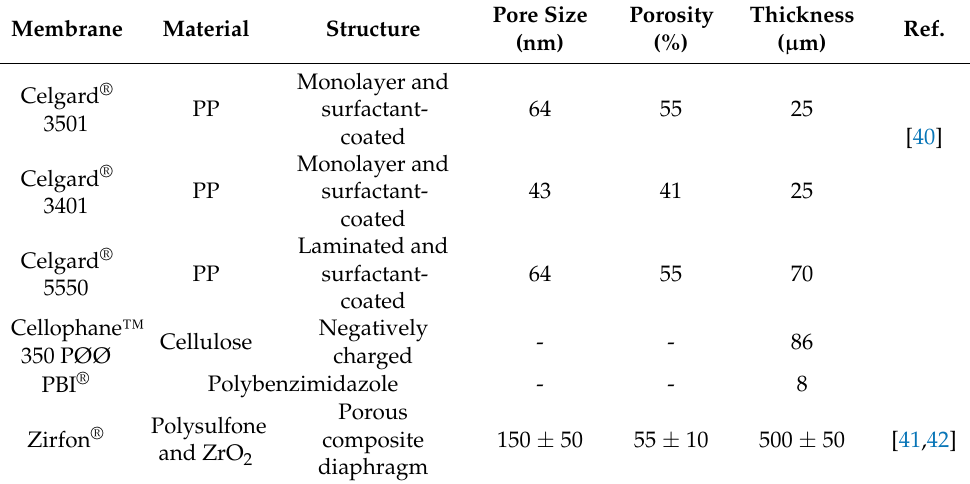
Table 1. Properties of the commercial membranes tested in this